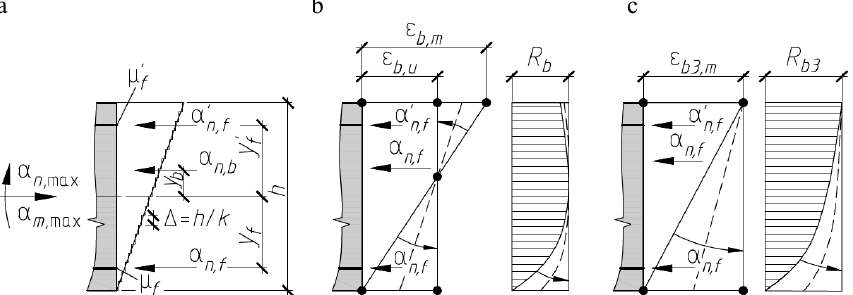
Fig. 1. Design diagram (a) and design models (b, c), which characterize the transition of a normal section from an eccentric compression with an eccentricity of application of a longitudinal force on the boundary of the section core to its axial compression for FFE elements without external reinforcement (b) and external reinforcement